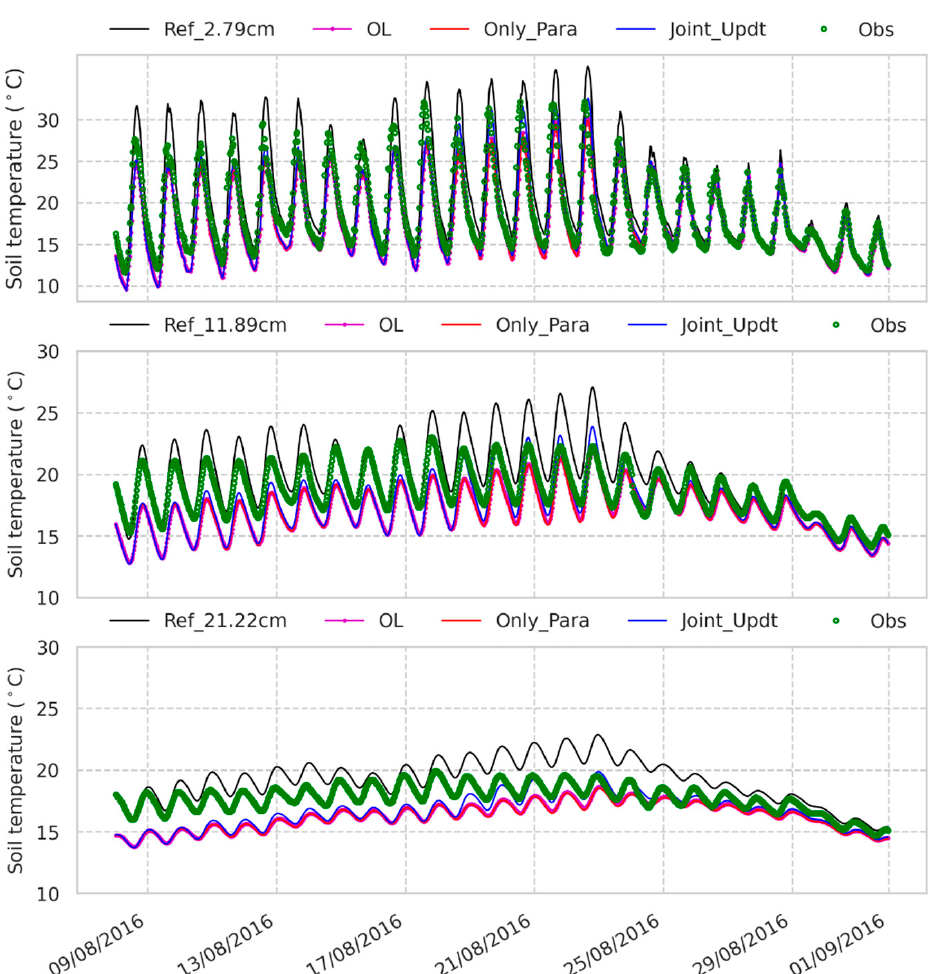
Figure 10. Soil temperature time series from 7 August 2016 to 31 August 2016 of the second (2.79 cm), third (11.89 cm) and fourth (21.22 cm) layers in the reference (Ref), open loop (OL) experiments, experiment with only soil properties updated (Only_Para) and experiment with both soil properties and soil moisture estimates (Joint_Updt) by assimilating SMAP T H . Obs denotes profile soil moisture measured by 5TM ECH2O probes deployed at the ELBARA-III radiometer region on the Maqu site [38].